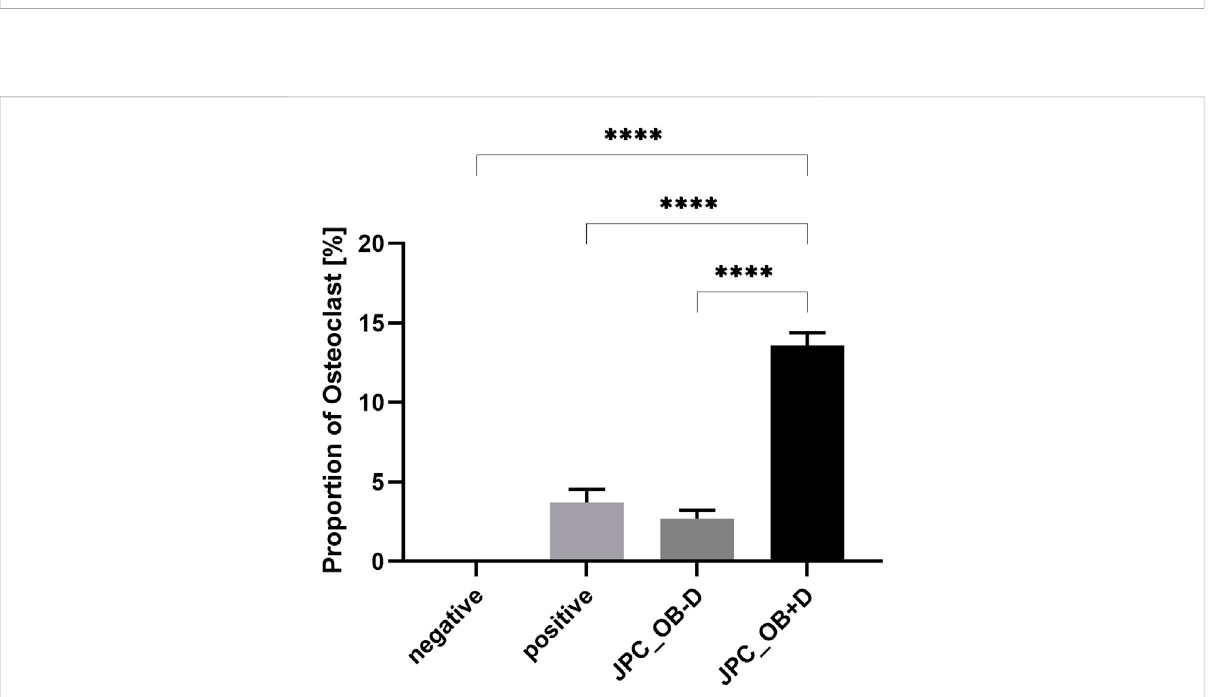
FIGURE 11 Quanti fi cation of mature osteoclasts in the overall cell population. M-CSF + RANKL stimulated PBMCs were incubated with secretome (10x) of JPCs treated with osteogenic medium with dexa (JPC_OB+D) and without dexa (JPC_OB − D). Controls were treated with M-CSF (negative) and M- CSF+RANKL (positive). After 6 days cells were fi xed and stained for actin (phalloidin-alexa fl uor 488) and nuclei (Hoechst). Microscopic images were analyzedusingImageJsoftware.Cellswerede fi nedasosteoclastswhenhavingthreeormorenucleiandshowinganactinring.Means±SEMof osteoclast proportions were calculated and compared using multiple t-tests (n = 3, ****= p < 0.0001).